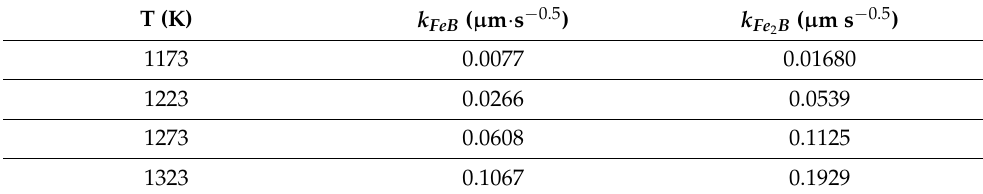
Table 4. Estimated values of k FeB and k Fe T (K)